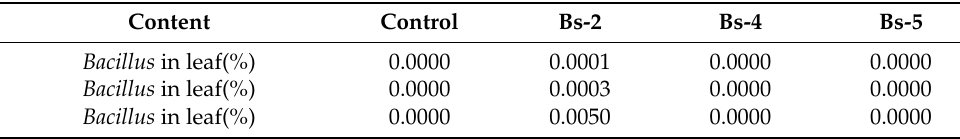
Table A3. Saprophytic Bacillus effected on the leaf of Aquilaria sinensis